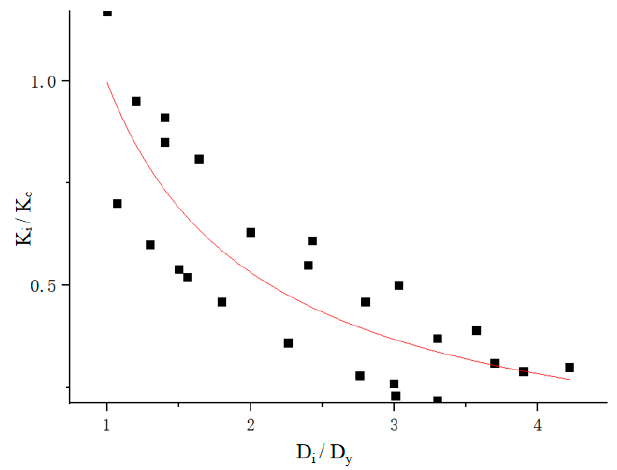
Figure 12. The relationship between the deformation ratio and stiffness ratio. The post-yielding stiffness calculation formula obtained from the fitting curve: